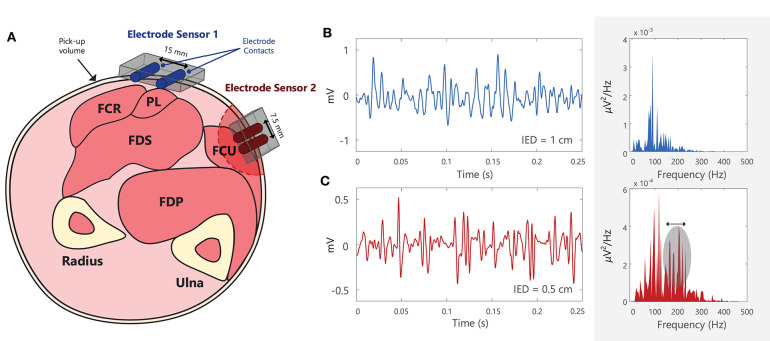
(A) Schematic of the cross-section of the forearm, with the approximate locations of different muscles: flexor carpi radialis (FCR), palmaris longus (PL), flexor digitorum superficialis (FDS), flexor digitorum profundus (FDS), and flexor carpi ulnaris (FCU) (62). Note that electrode contacts should be placed approximately parallel to the muscle fiber direction. Electrode sensor 1 is placed over PL, but it will detect muscle activity (or crosstalk) from the adjacent/deep muscles, FCR and FDS. Electrode sensor 2 has a smaller inter-electrode distance (IED) than Electrode sensor 1 and will thus have a smaller pick-up volume. (B,C) Two EMG signals recorded using different electrodes with different IEDs, shown in both the time and frequency domains. EMG signals recorded using smaller IEDs can capture more high frequency components when compared with larger IEDs. Note that this diagram is for illustrative purposes and that the power spectra of the EMG signals cannot be directly compared between (B) and (C), as they were recorded in different muscles, under different conditions, using different electrodes. See Example (xi) in Tutorial Code.